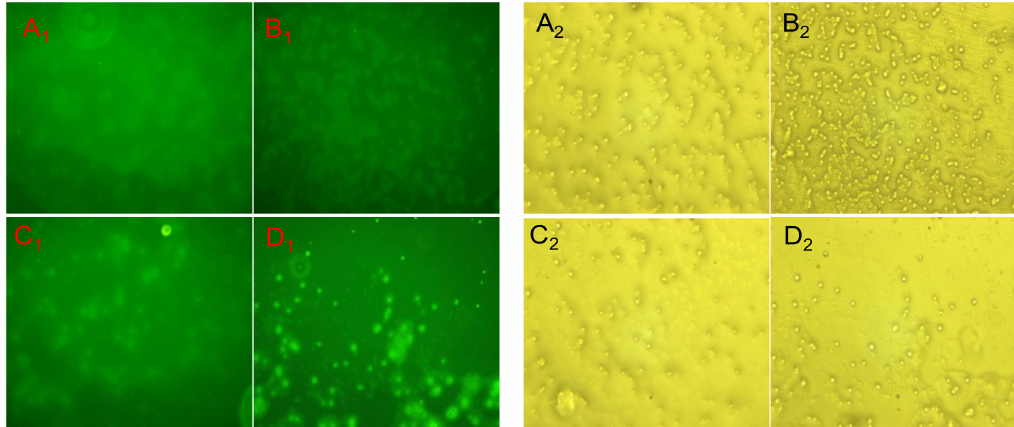
Figure 10. The fluorescent and white light images of FITC-NTCII P combined with CD8 + T cells at different concentrations. ( A 1 , B 1 , C 1 , D 1 ) were the results of CD8 + T cells surface antigen recep- tor binding fluorescence photographed after 5 days of co-culture with CD8 + T cells at 3 µ g/mL, 5 µ g/mL, 10 µ g/mL and 50 µ g/mL of FITC-NTCII respectively; ( A 2 , B 2 , C 2 , D 2 ) were the results of their corresponding white light